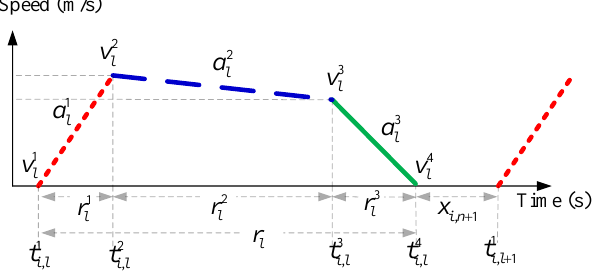
Figure 3. General process of a subway train running at a